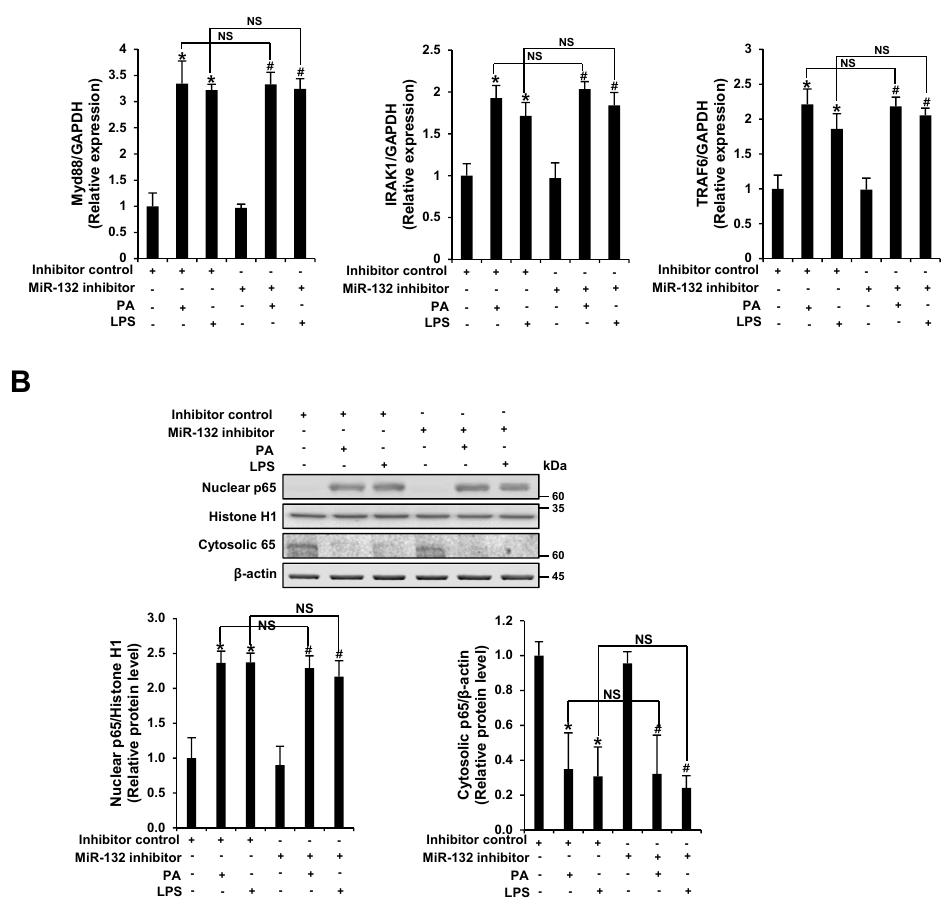
Figure 4. miR-132 does not regulate PA-induced TLR signaling. THP-1 cells were transfected with an inhibitor negative control or inhibitor of miR-132 at 20 nM for 48 h before being treated with 200 µ M PA or 1 µ g/mL LPS (as a positive control) for 12 h. ( A ) The mRNA levels of MyD88, IRAK1, and TRAF6 were examined by quantitative RT-PCR; ( B ) Nuclear and cytosolic fractions were subjected to Western blot analysis using antibodies specific for NF- κ B p65, histone H1, and β -actin. Histone H1 and β -actin were used as a loading control. All results are representative of three independent experiments. * p < 0.05 compared with the inhibitor negative control-transfected cells, and # p < 0.05 compared with the miR-132 inhibitor-transfected cells. NS, no